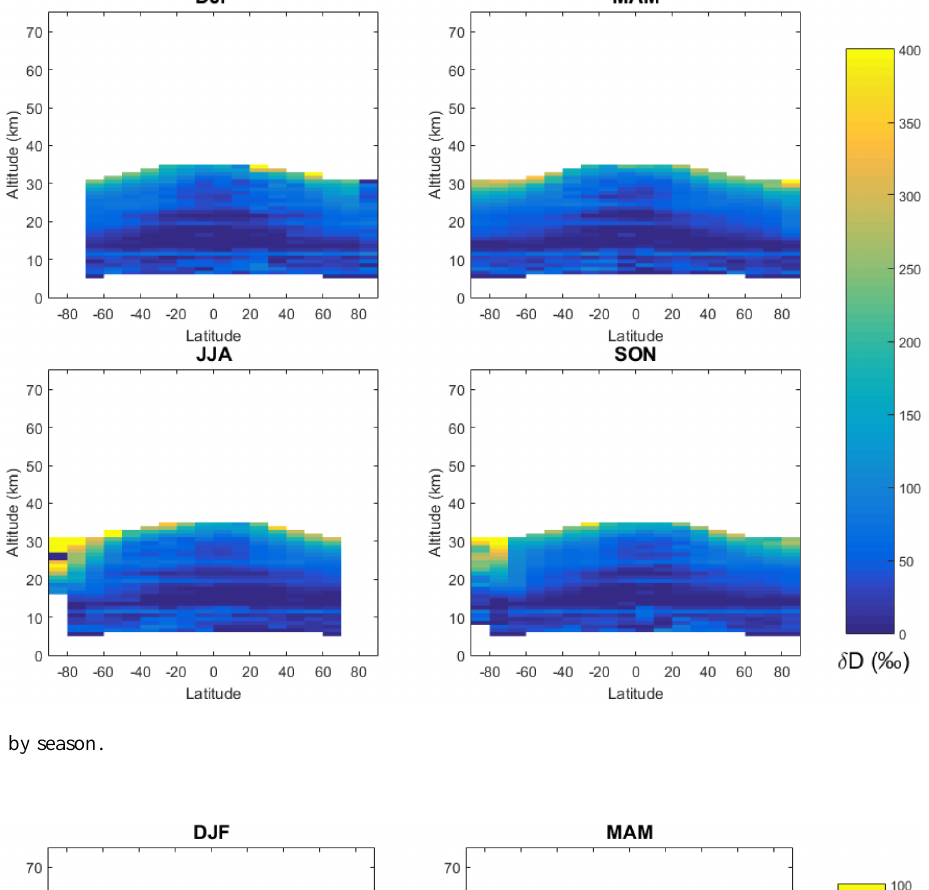
Figure 4. ACE δ D by season.